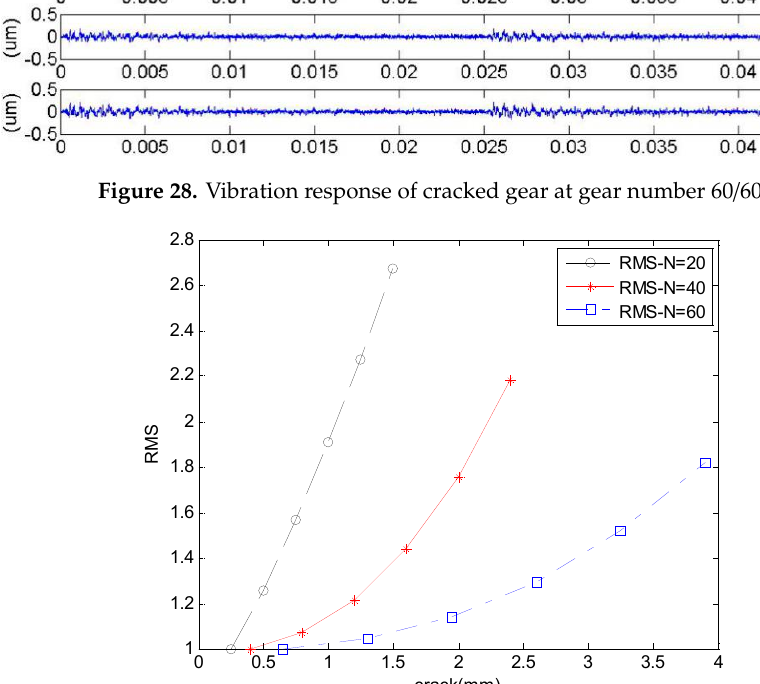
Figure 29. RMS for the vibration response under changing tooth number.